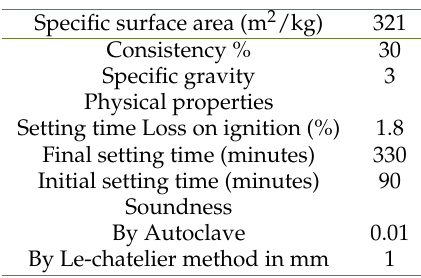
Table 1. Physical properties of